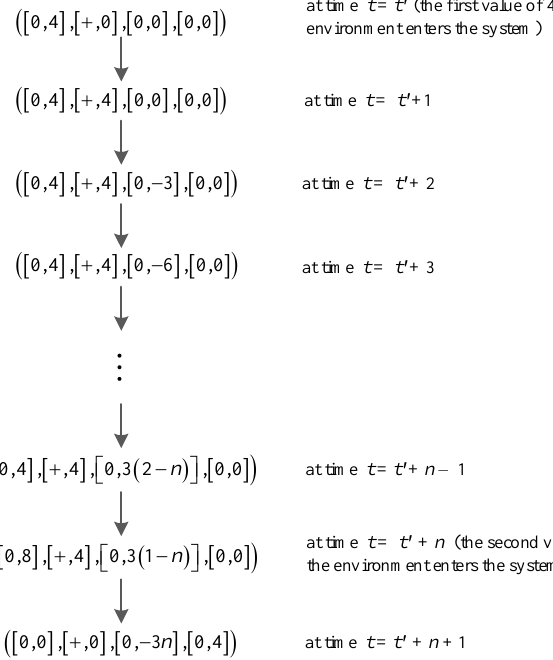
Figure 7. Configuration dynamics of the INPUT module.